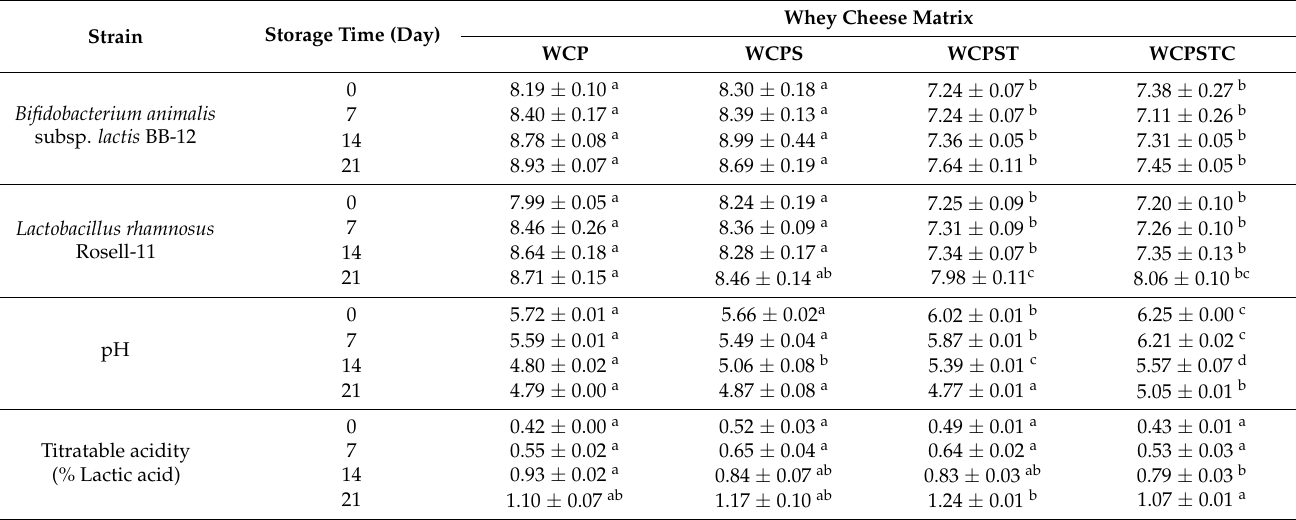
Table 3. Evolution of viable counts (log CFU g − 1 ) and physicochemical parameters throughout storage period (average ± standard